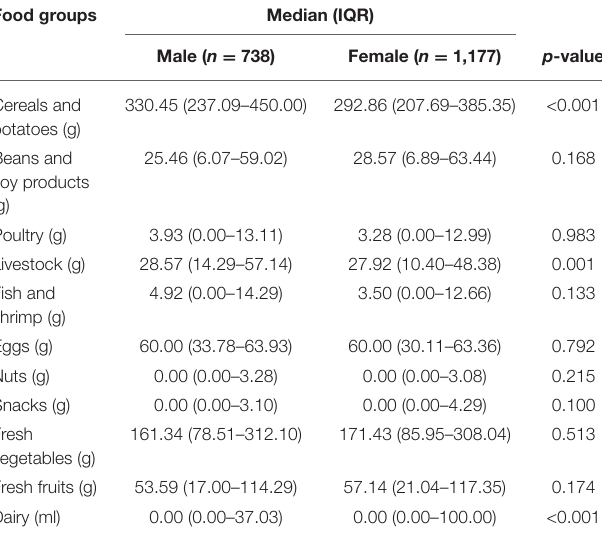
TABLE 2 | The distribution of baseline characteristics between study participants who are depressed or